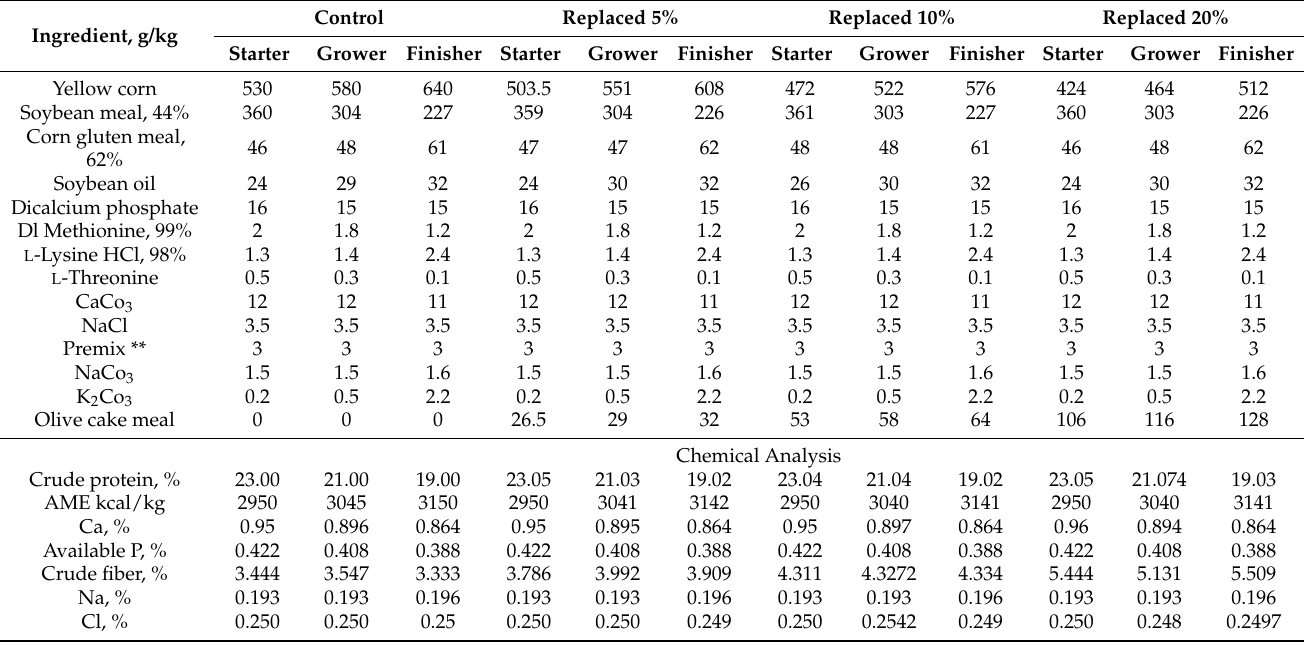
Table 1. Composition of the experimental starter (1–11 day), grower (11–24 day), and finisher (25–35 day) diets *. Ingredient, g/kg Yellow